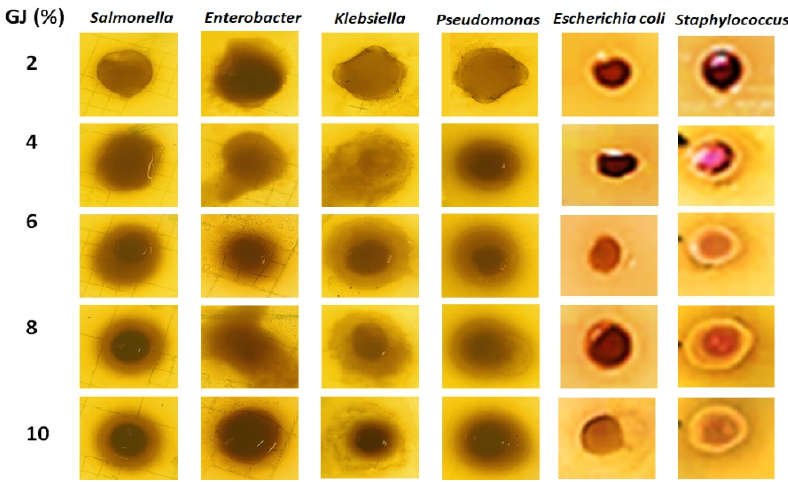
Figure 4. Effects of different concentrations of grape juice (GJ) on the antimicrobial activity of obtained NS PC edible films.